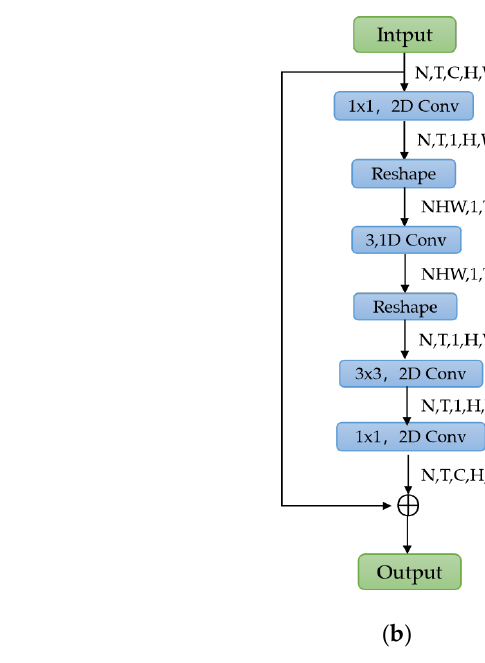
Figure 4. The structures of the proposed motion encoder (ME) and (2 + 1)D spatial and temporal module. ( a ) The structure of motion encoder; ( b ) The structure of (2 + 1)D spatial and temporal module.